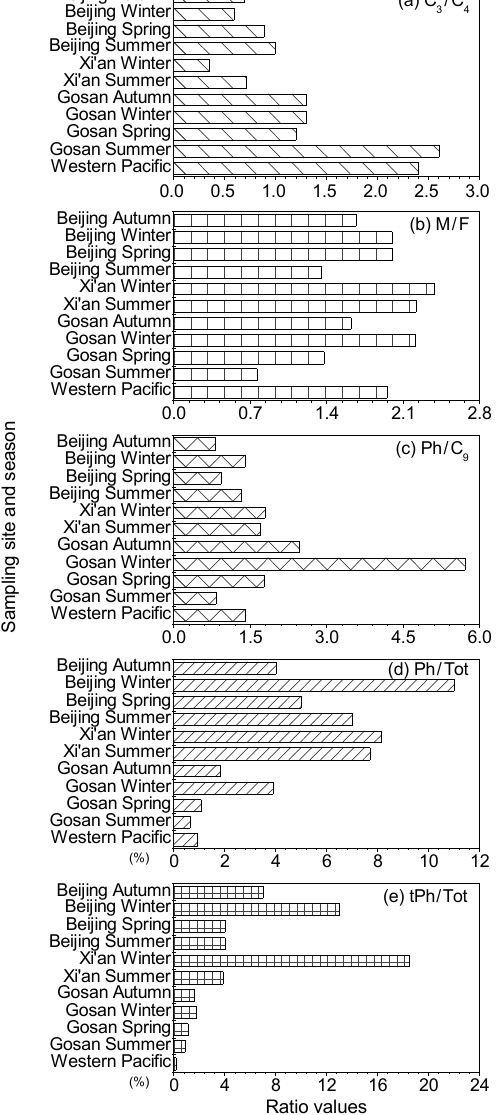
Figure 5. Mean mass ratios of (a) C 3 / C 4 , (b) M / F, (c) Ph / C 9 , (d) Ph / Tot and (e) tPh / Tot from this study compared with those in Xi’an (Wang et al., 2012); Gosan, Jeju Island (Kundu et al., 2010a); and the western Pacific (H. Wang et al., 2006) aerosols.